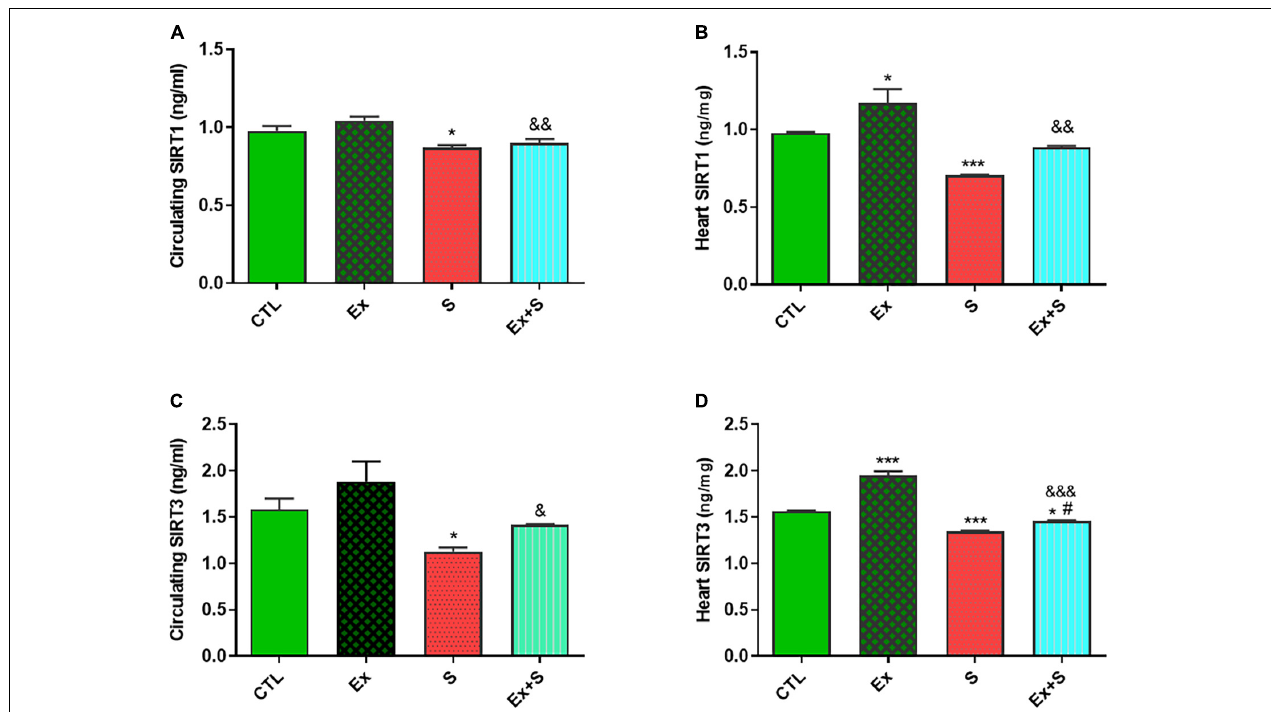
FIGURE 5 | Effects of waterpipe smoke inhalation on sirtuin 1 (SIRT1) levels in serum (A) and in the heart (B) , and sirtuin 3 (SIRT3) levels in serum (C) and in the heart (D) in experimental groups. CTL, control group; Ex, group subjected to exercise training for 8 weeks; S, group subjected to waterpipe tobacco smoke inhalation for 8 weeks; Ex + S, group subjected to exercise training and waterpipe tobacco smoke inhalation for 8 weeks. The results are presented as mean ± SEM, n = (6–7). * P < 0.05; *** P < 0.001 vs. CTL; # P < 0.05 vs. S; & P < 0.05; && P < 0.01; &&& P < 0.001 vs. Ex.